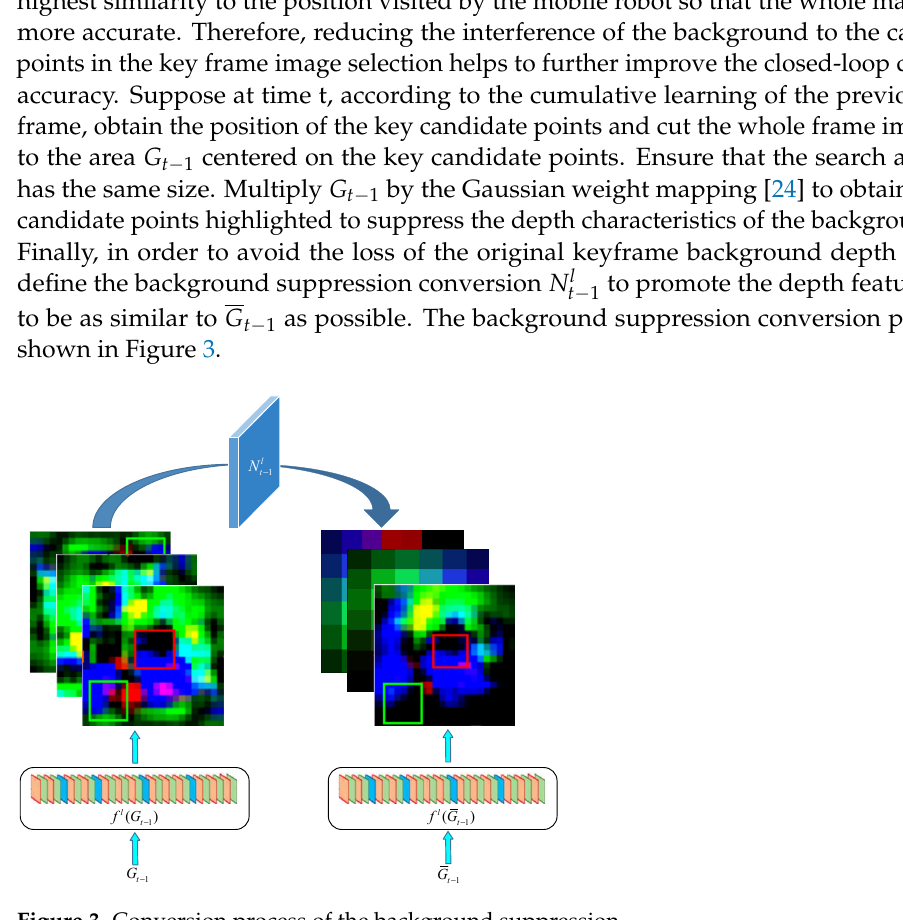
Figure 3. Conversion process of the background suppression.